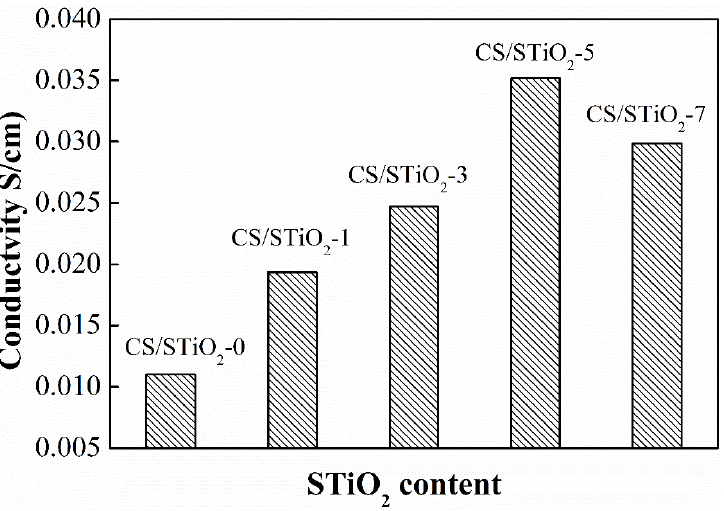
Figure 8. Proton conductivity of CS control and CS/STiO 2 nanocomposite membranes.